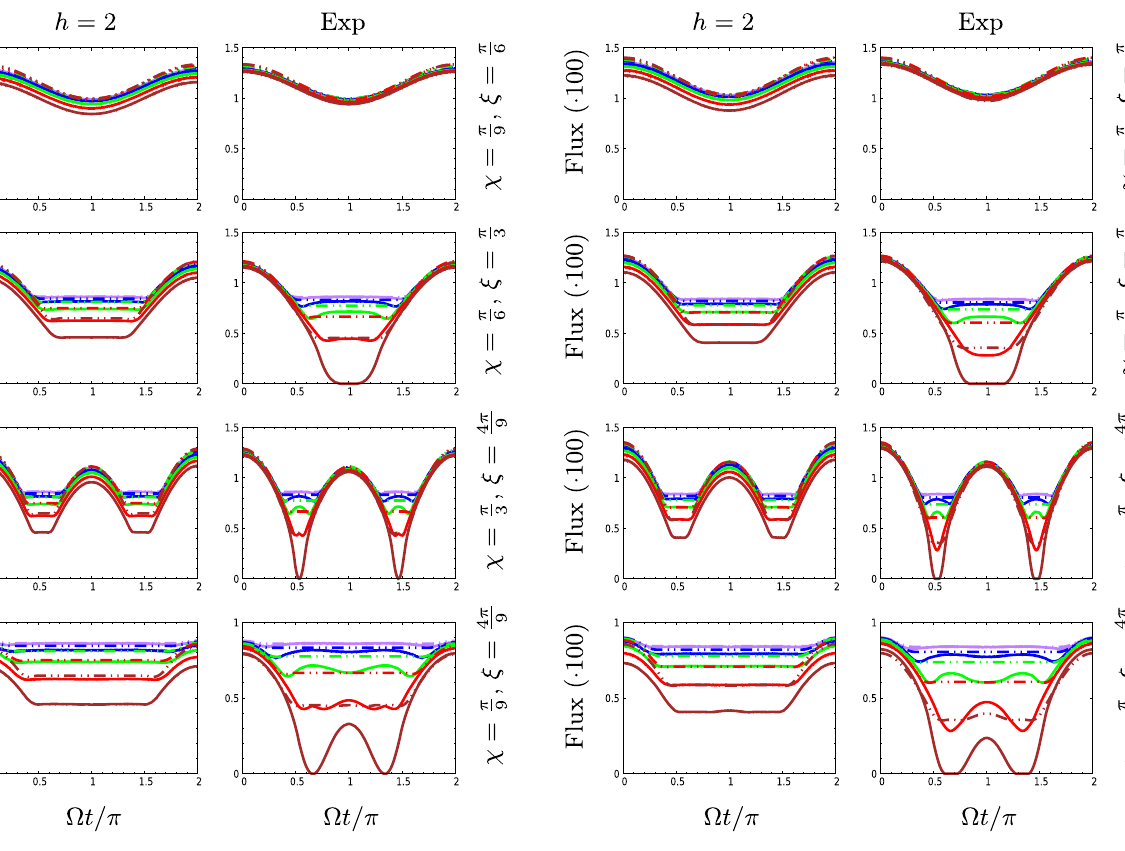
Fig. 35 Analytical pulse profile for two identical, antipodal caps. Reissner–Nordström, R = 6 M , q ∗ = − ( 0 . 50 M ) 2 , θ c = 5 o . Purple, blue, green, green, red and brown lines correspond to (cid:11) = 0 . 1, 0 . 2, 0 . 3, 0 . 4 and 0 . 5 respectively. The solid lines correspond to the numerical